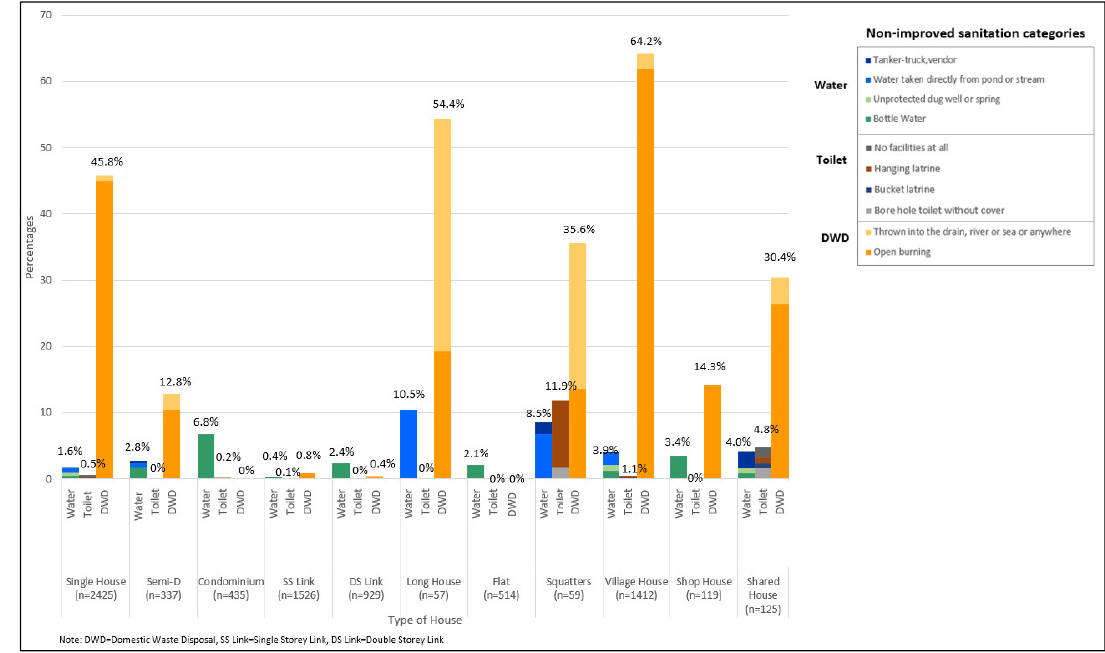
Int. J. Environ. Res. Public Health 2020 , 17 , x FOR PEER REVIEW Figure 4. Sanitation categories by house type. Figure 4. Sanitation categories by house type.